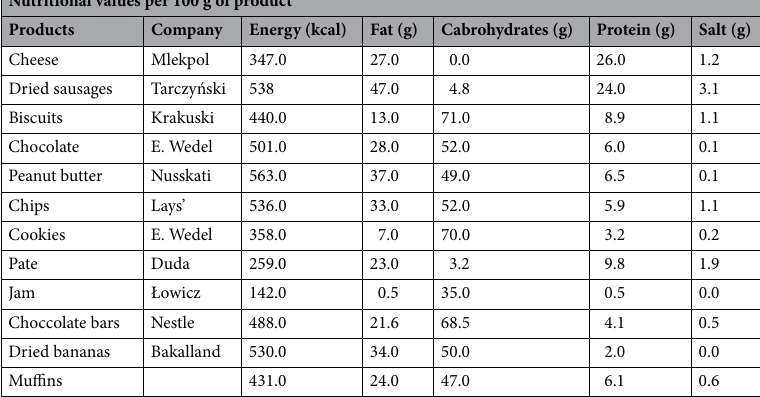
Table 1. Products and their nutritional values of CAF diet